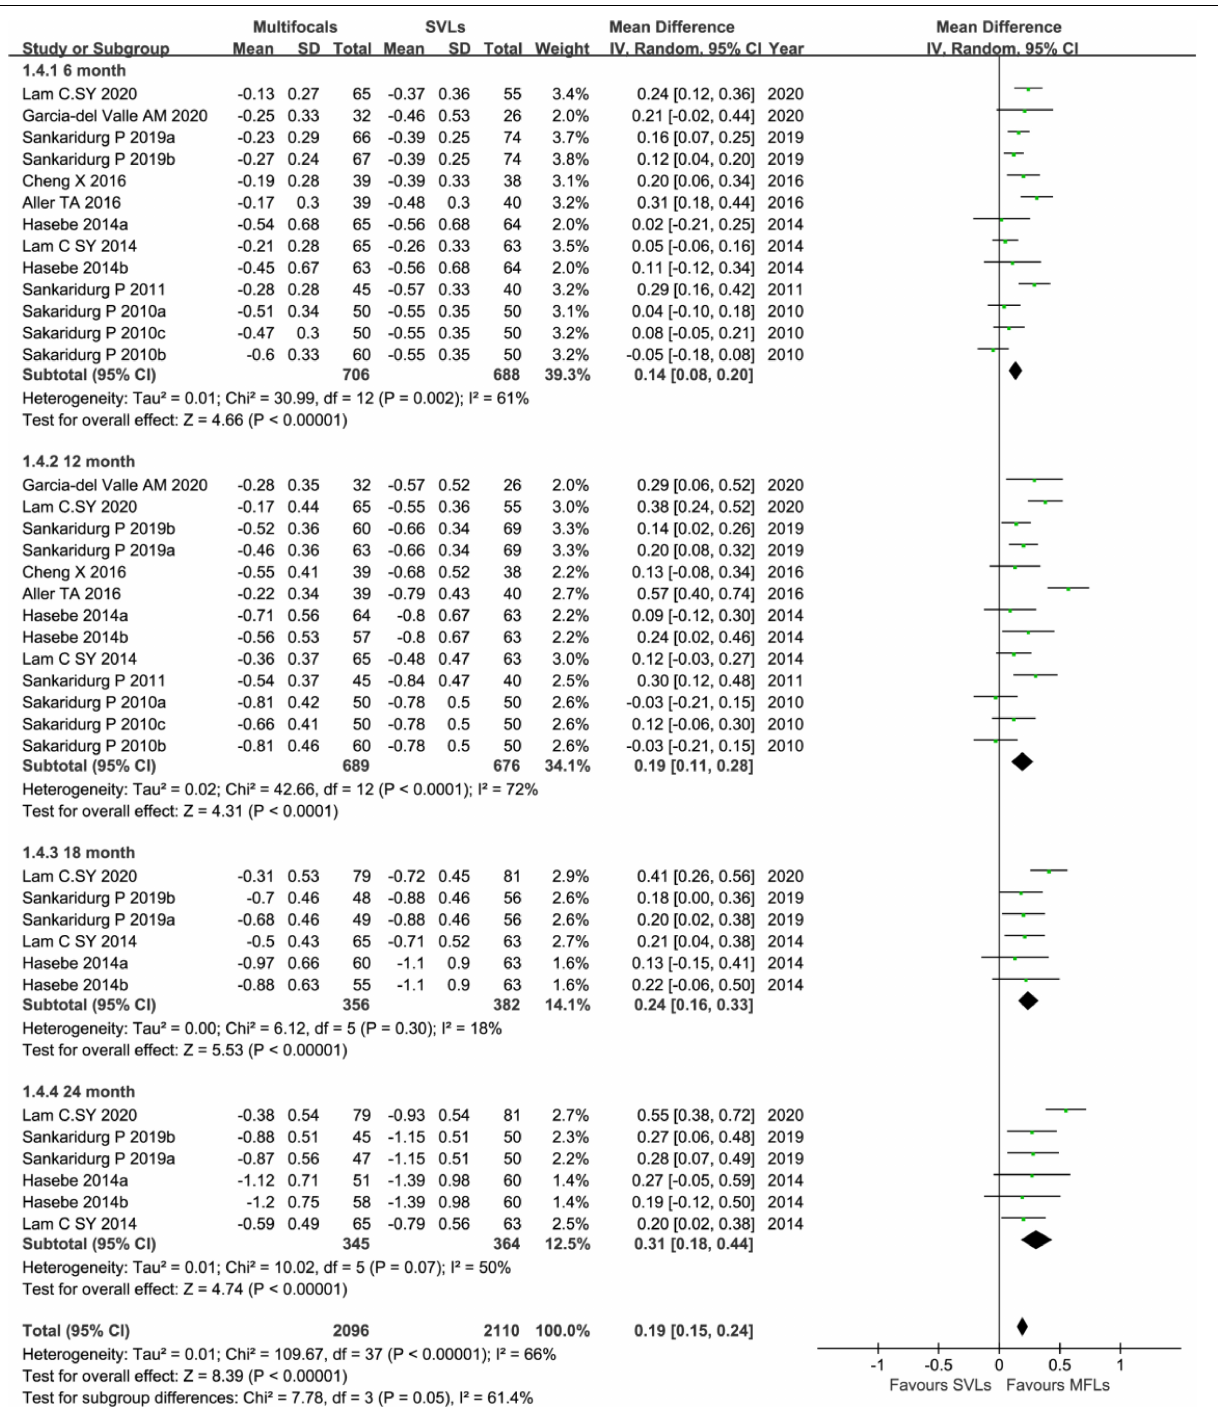
FIGURE 5 | Forest plot about the change of SER in 6-months interval visit